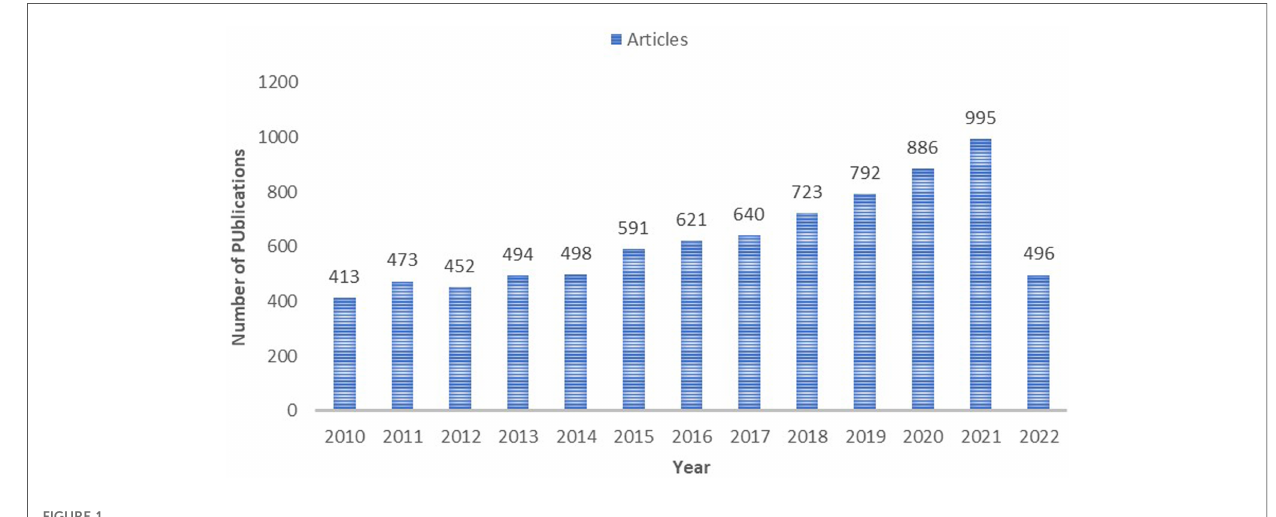
FIGURE 1 The annual growth trend of publication